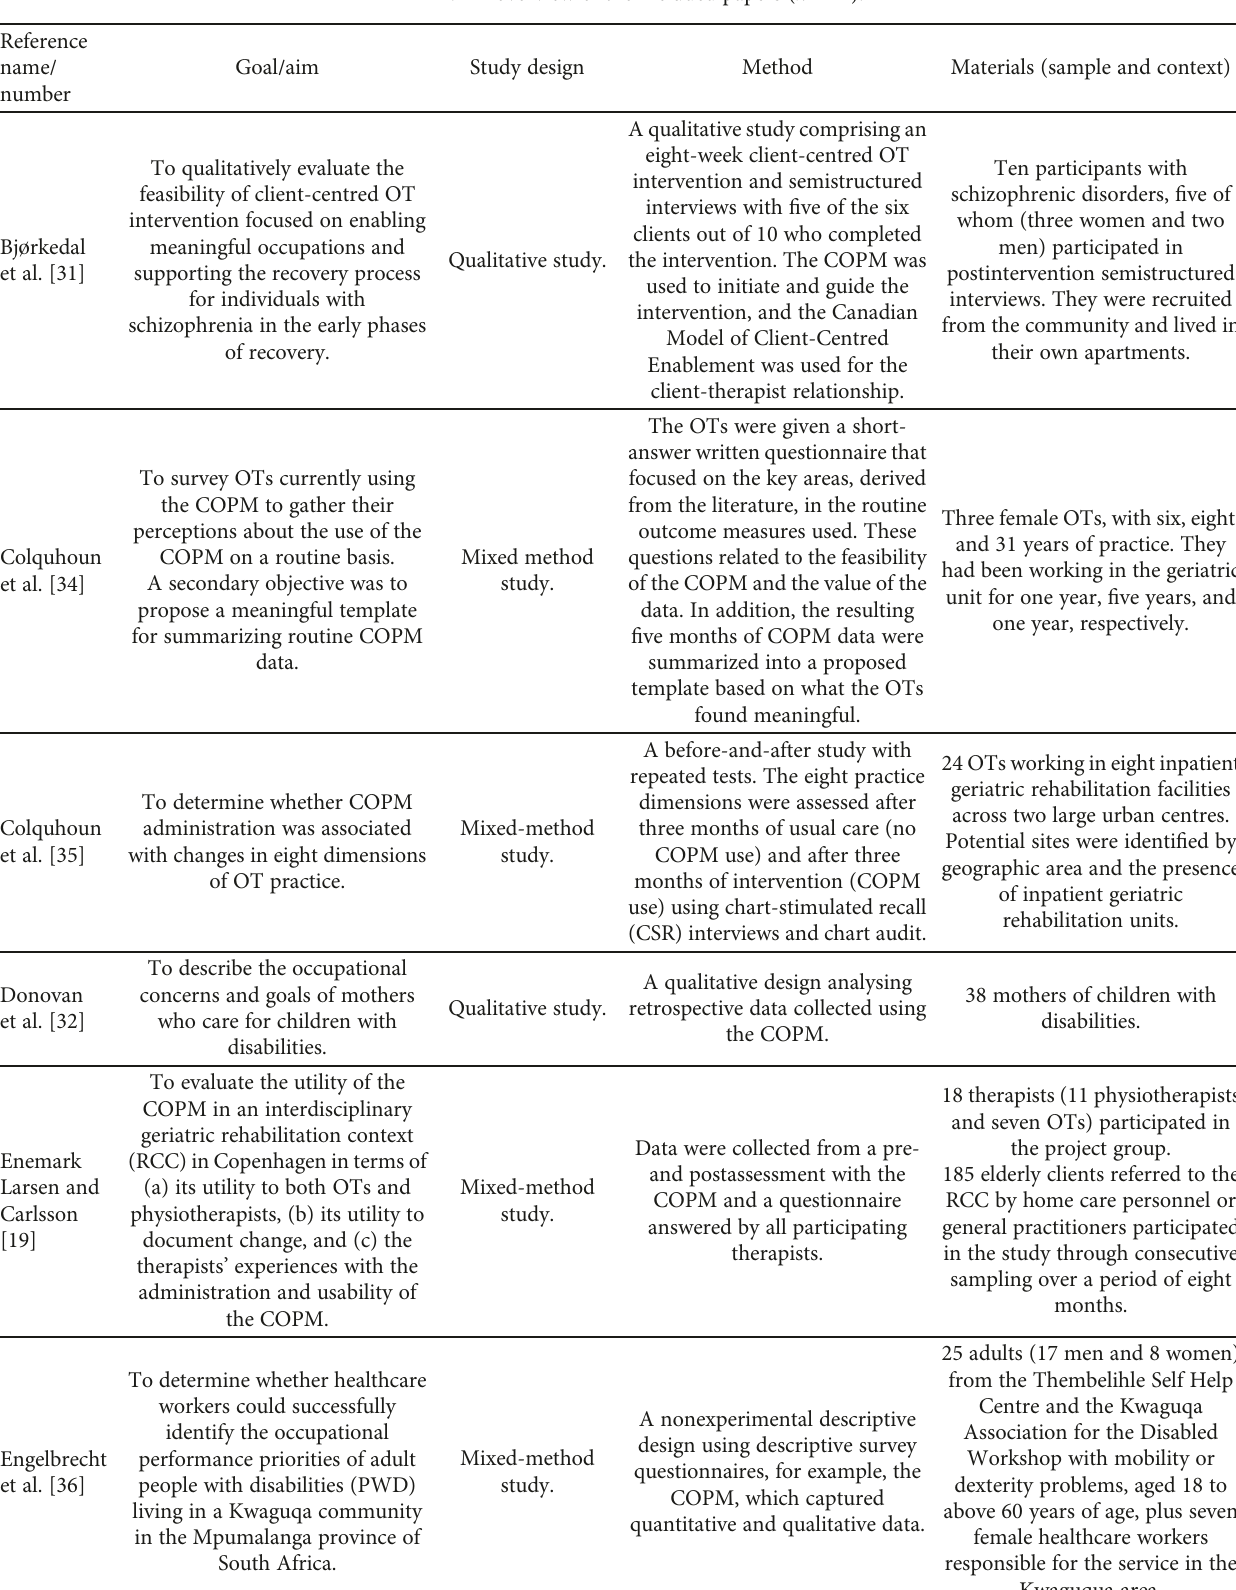
Table 1: An overview of the included papers ( n = 12